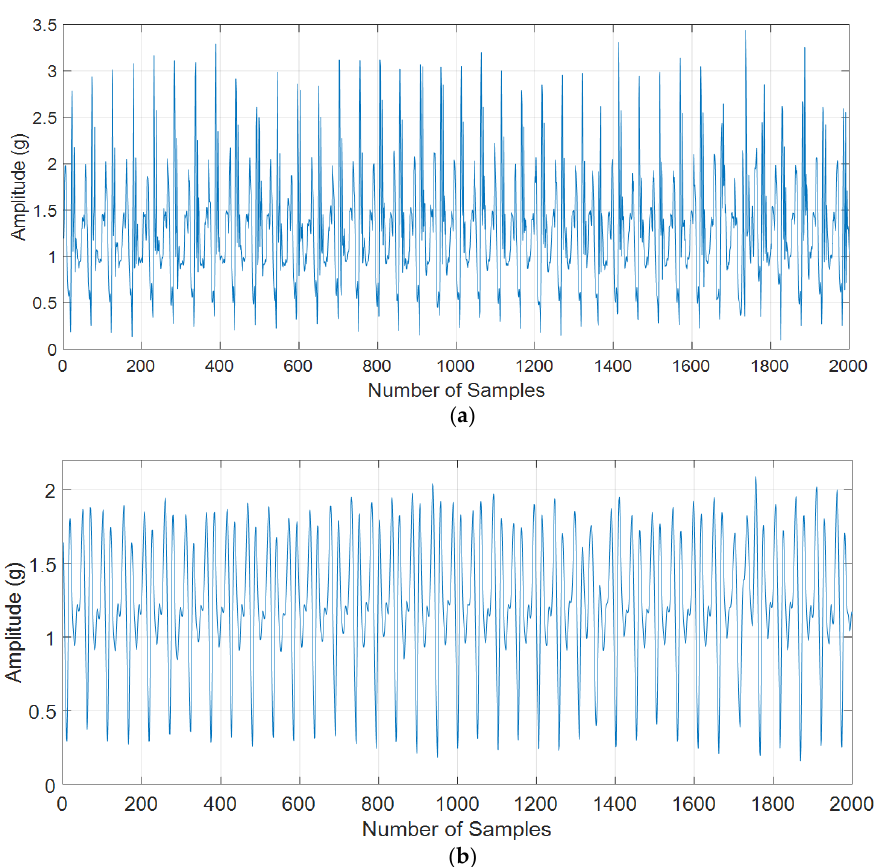
Figure 2. The signal before and after using the low-pass filter: ( a ) The raw signal before using the low- pass filter; and ( b ) The signal after using the low-pass filter.